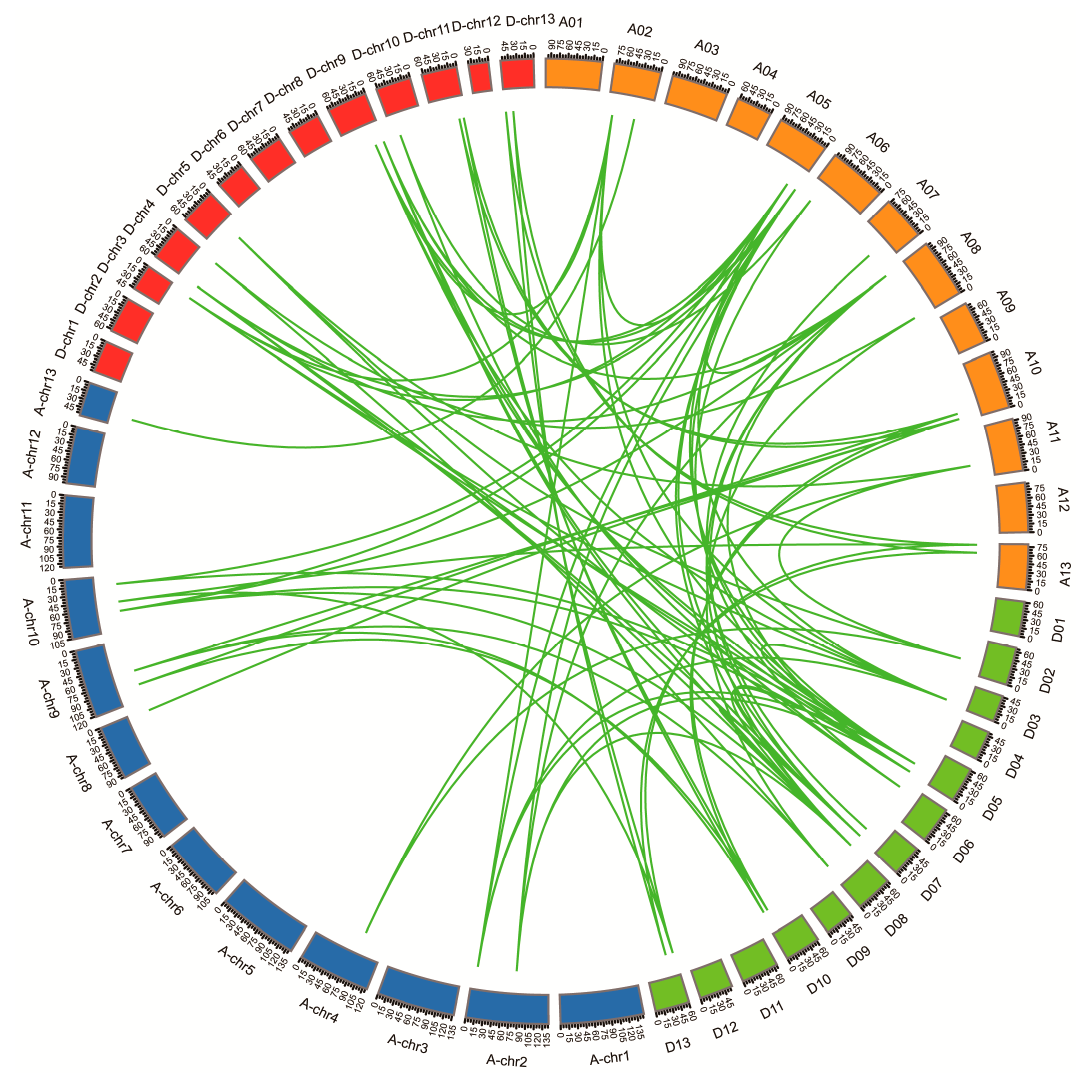
Figure 3. Gene duplication among HH3 genes in cotton including G. arboreum (A-genome), G. hirsutum (At and Dt sub-genome), and G. raimondii (D-genome). Red lines linking two different genes represent the orthologous pairs diverged from the same ancestor. A01–A13 (mustard colored blocks) represent the chromosomes of At sub-genome and D01–D13 (light green colored blocks) exhibit the chromosomes of Dt sub-genome. Similarly, A-chr1-A-chr13 (blue colored blocks) and D-chr1-D-chr13 (red colored blocks) demonstrate G. arboreum and G. raimondii chromosomes, respectively.